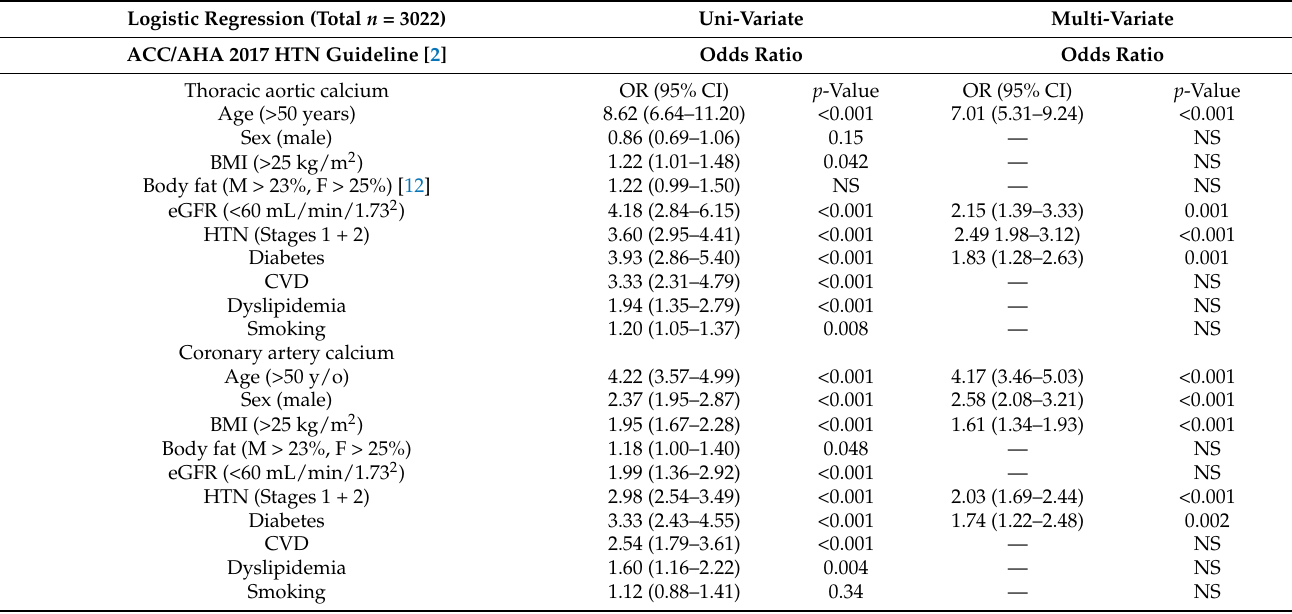
Figure 2. Probability of the presence of TAC, predicted by each blood pressure component (SBP, DBP and PP), and HTN stages defined in the 2017 ACC/AHA HTN guidelines in original cohort (left), compared with results obtained from the sensitivity analysis (right), which excluded the subjects with known CVD and ongoing HTN medication use. Table 3. Probability of the presence of TAC and CAC, according to the backward, stepwise, uni- and multi-variate regression models.